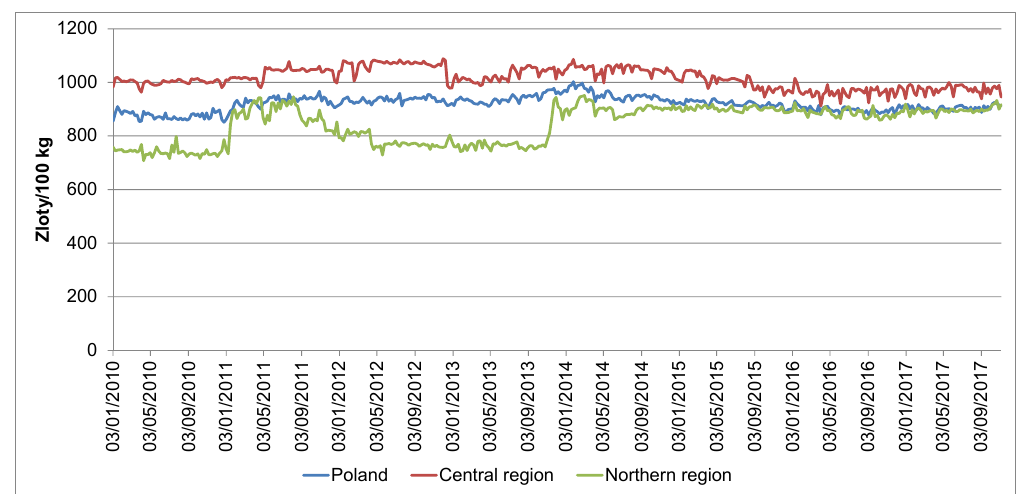
Figure 3. Weekly prices of curd per kg in the country and two regions, 3 January 2010 to 5 November 2017, in PLN.